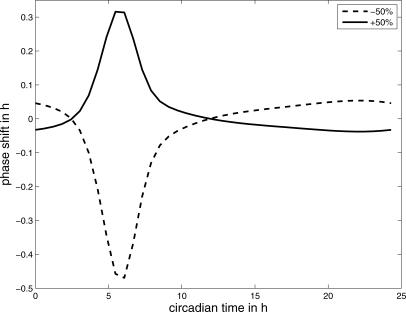
Phase Response Curve for CK1 ConcentrationThe phase response indicated by the ordinate is the permanent effect that was caused by a 50% up or down shift in active kinase concentration of 30 min duration. A positive phase shift indicates a phase advance, a negative one phase delay. The starting time of the step change corresponds to the time indicated by the abscissa. Circadian time zero corresponds to dawn.